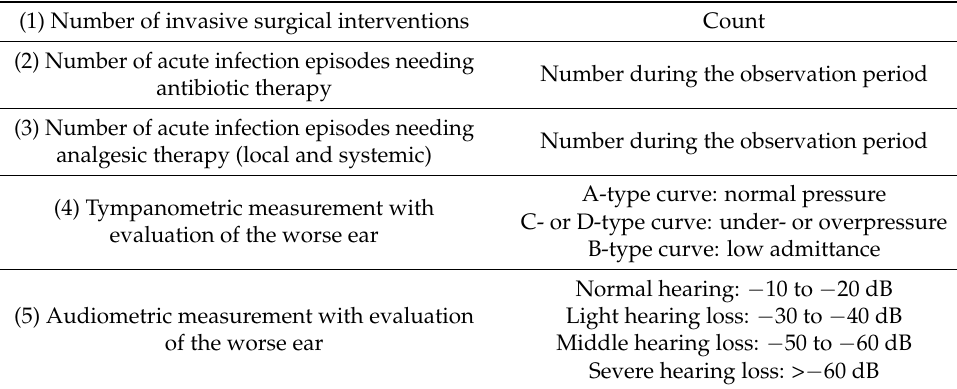
Table 1. Primary outcome variables.